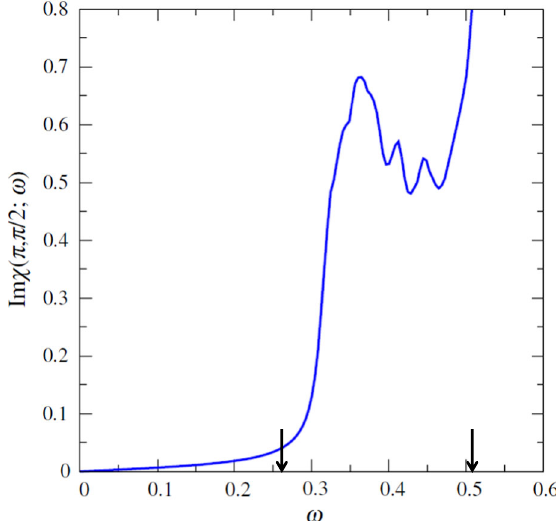
Fig. 3 The imaginary part of the dynamical spin susceptibility for the alkaline iron selenides at wavevector q = ( π , π /2), for a dominant s τ 3 pairing for parameters J 2 = 1.5, A O = 0.3, and A L = 0.9. The arrows show twice the minimum and maximum gaps (see Fig. 4b). There is a sharp feature ar ω ≈ 0.36 within the bounds of twice the effective gap and below the p – h threshold of roughly 0.41 associated with this